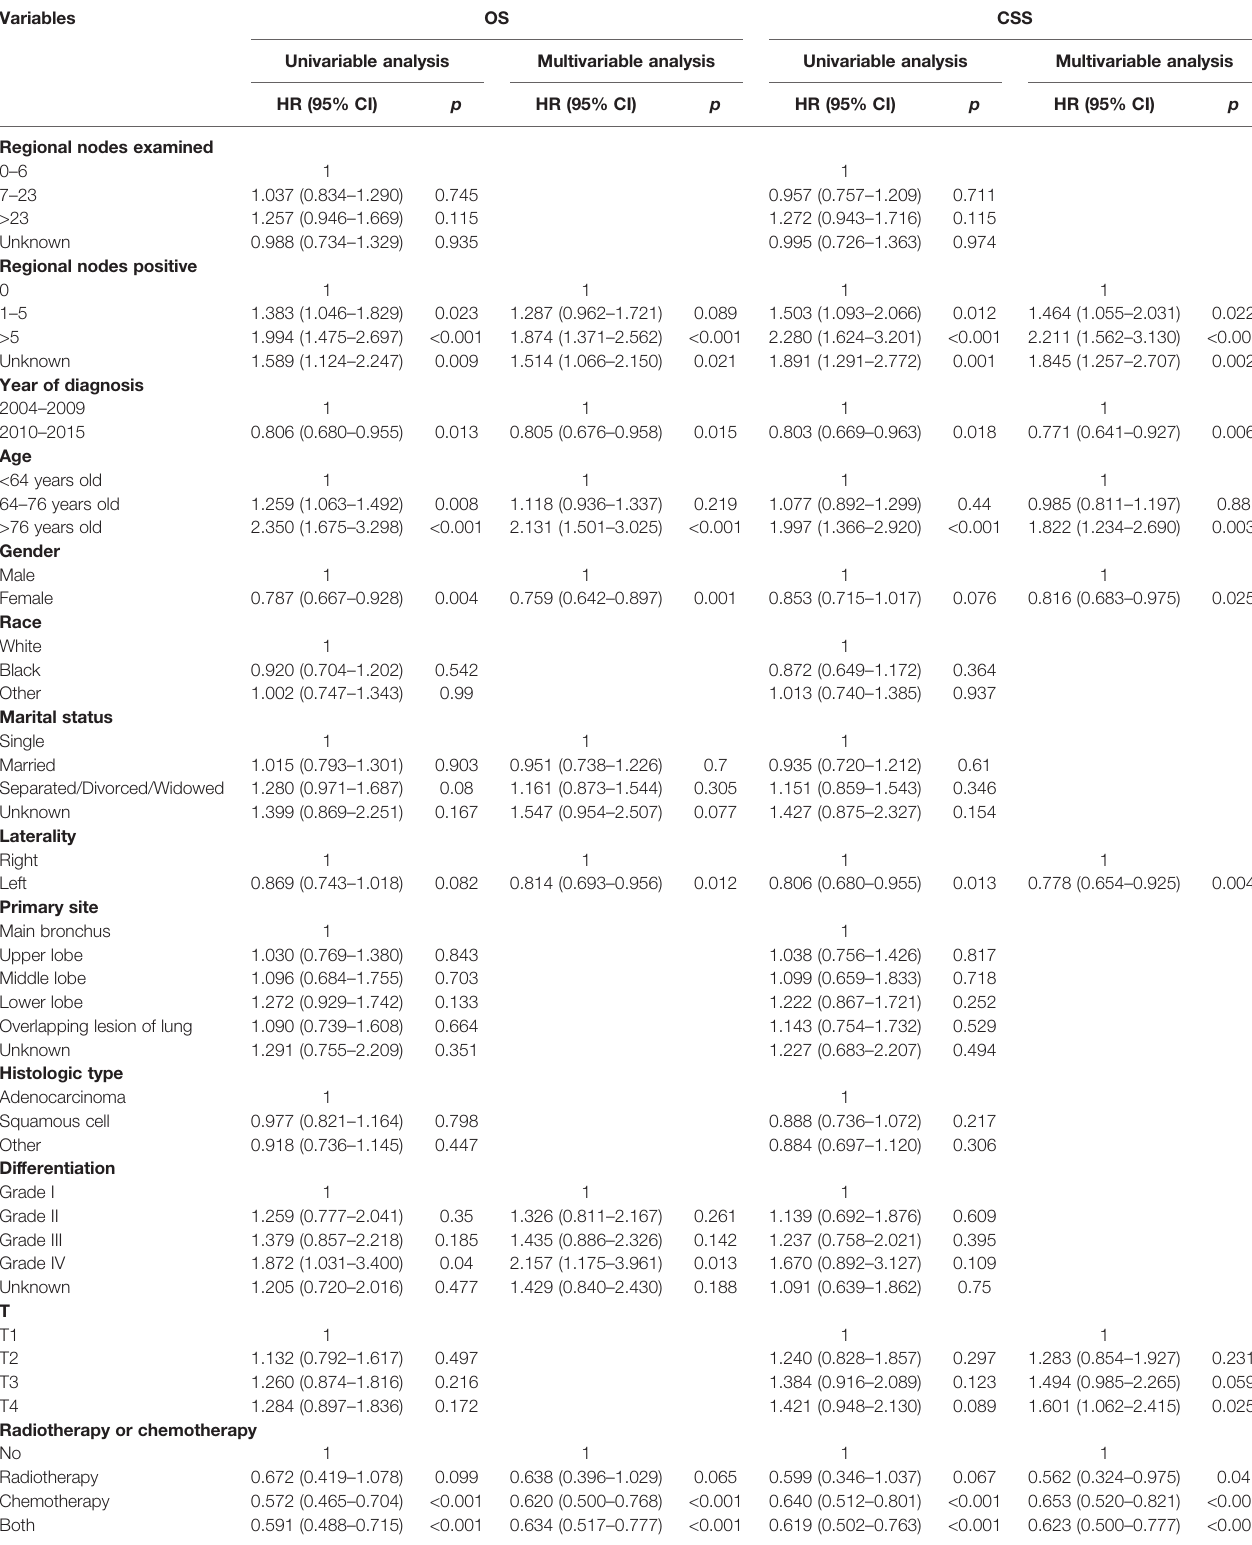
TABLE 4 | Cox regression analysis of in fl uence of regional nodes examined and regional nodes positive on OS and CSS in stage T1 – 4N2M0 NSCLC patients who underwent